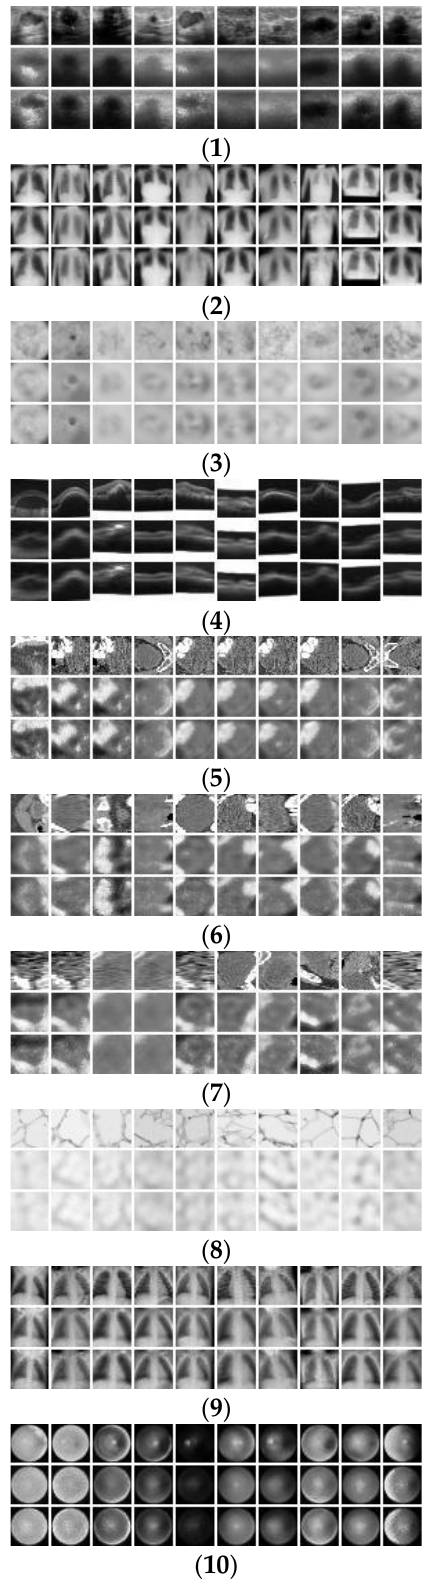
Figure 24. Reconstruction images on the MMNIST data set. For each subfigure, the top row reveals the original images, the middle row reveals the recovery images of AE, and the bottom row reveals the recovery images of RCDAE.